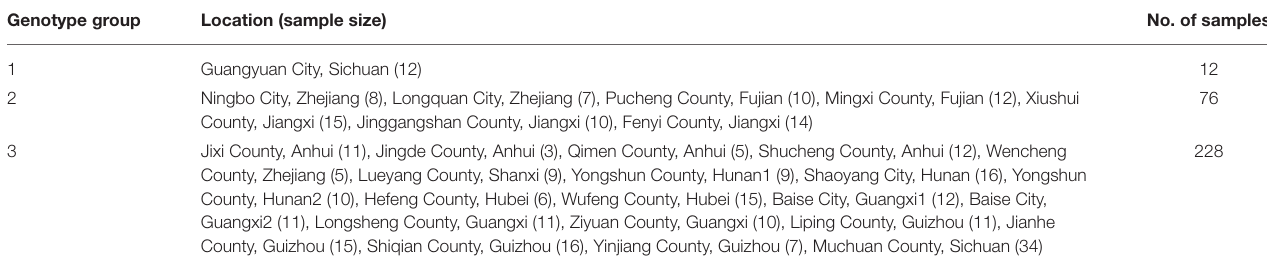
TABLE 4 | C. paliurus g enotype structure differentiation (Li X. C. et al., 2017). Genotype